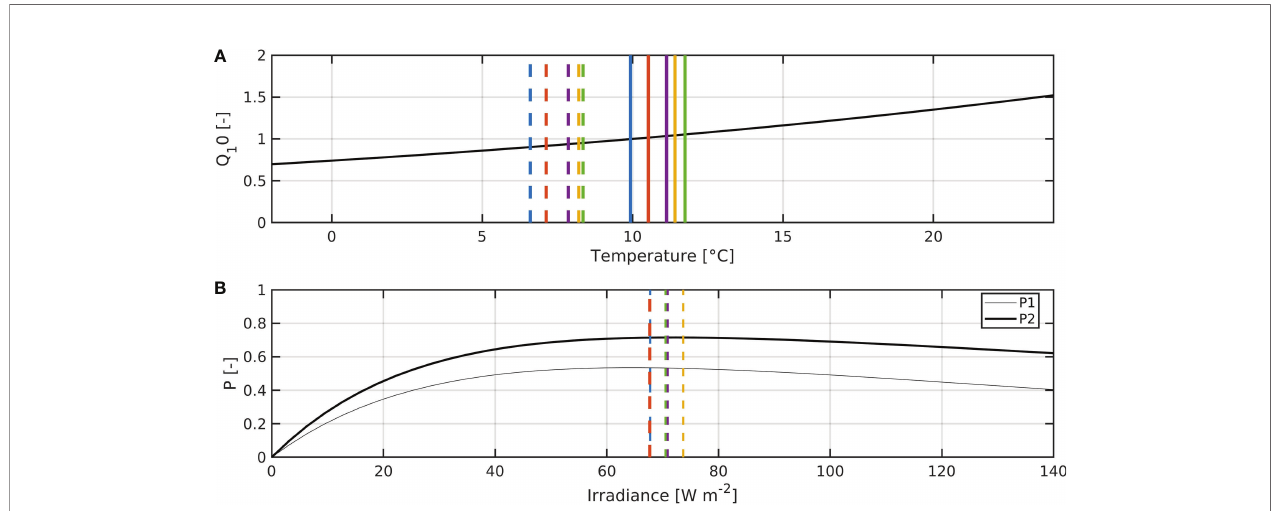
FIGURE 2 | (A) Q 10 -term. Dashed vertical lines show mean temperatures for March to May 1950 – 1954 (blue), 2000 – 2004 (red) and 2050 – 2054 (yellow: RCP2.6- SSP1, purple: RCP4.5-SSP2, green: RCP8.5-SSP5), and solid ones show the means of the 5-year period. (B) P – I curves for P1 (thin) and P2 (thick). Dashed vertical lines are the same as in the top panel, except that they show SWR